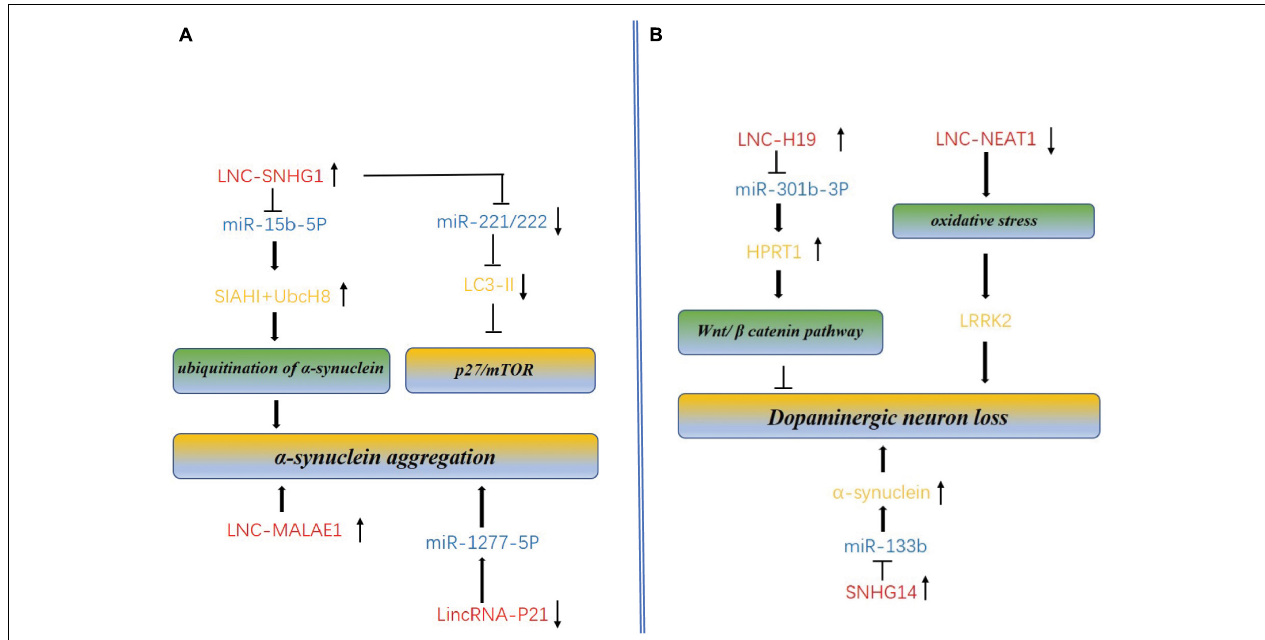
FIGURE 3 | Molecular mechanism of lncRNAs and miRNAs mediated accumulation of dopaminergic neuron loss, α -synuclein aggregation and autophagy in PD. (A) LncRNAs regulate α -synuclein aggregation and autophagy. SNHG1 and lnc-MALAE1 are highly expressed in AD, promotes the α -synuclein aggregation. SNHG1 also can inhibit autophagy by reducing the expression of mTOR. Linc-P21 is down-expressed in PD and promotes aggregation through overexpression of miR-1277-5P. (B) LncRNAs regulate dopaminergic neuron loss. Overexpression of the H19 could prevent dopaminergic neuron loss in the 6-OHDA-induced PD model by activating HPRT1-mediated Wnt/ β catenin signaling pathway via impairing miR-301b-3p-targeted repression of HPRT1 transcription. NEAT1 upregulation in dopaminergic neurons of PD may protect dopaminergic neurons from LRRK2-mediated damage under the oxidative stress. Overexpression of the ln_SNHG14 could promote dopaminergic neuron